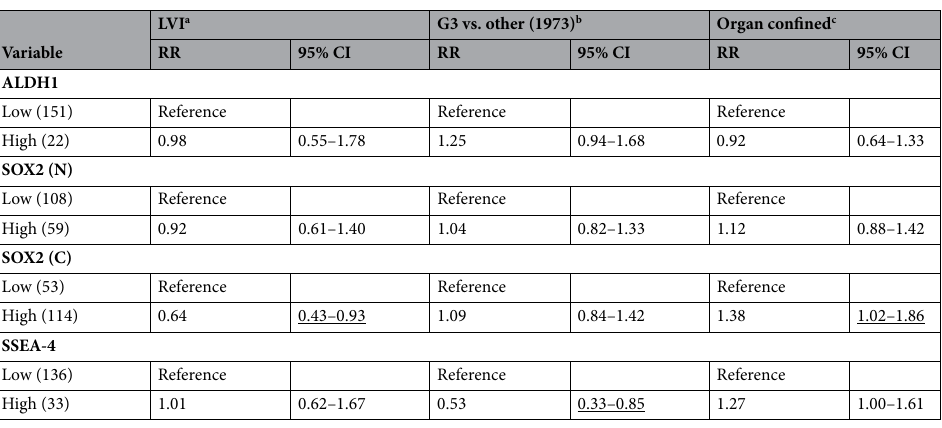
Table 3. Staining associations with clinicopathological characteristics in the RC-only cohort. Number of patients is shown in brackets for each subgroup. Comparison between high (H-score ≥ 4) and low (H-score < 4) expression. 95% Confidence intervals for risk ratio not including 1.0 are underlined. a Lymphovascular invasion. b Grade 3/3 according to WHO 1973 criteria. c Organ confinement defined by pT class 2 or lower and absence of lymph node metastasis.